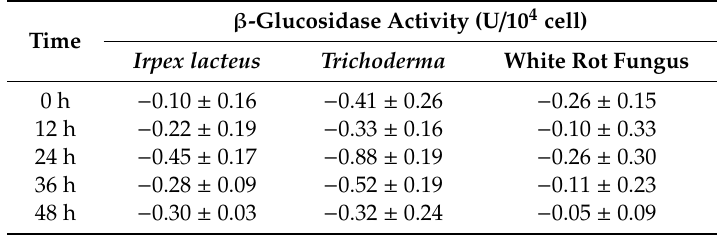
Table 5. Contents of β -glucosidase in the standard amygdalin solution with the three identified species. β -Glucosidase Activity (U / 10 4 cell) Time Irpex lacteus